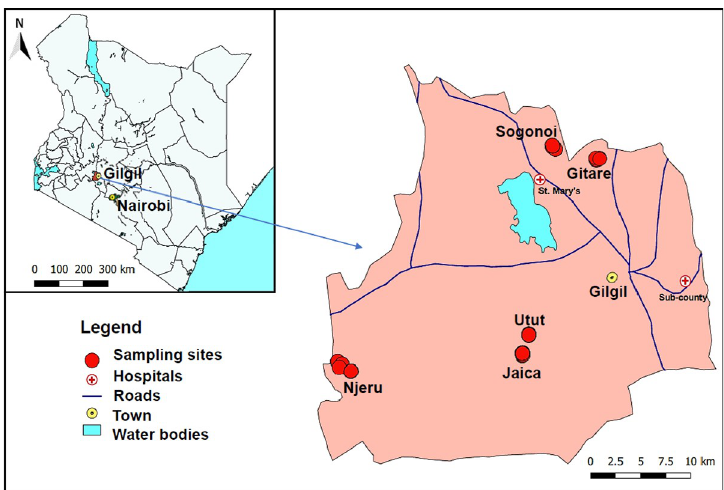
Fig 1. Map of Kenya (inset) and Gilgil Sub-county showing the location of the trapping sites. Gilgil covers an area of approximately 1348.4 Km 2 and has a population of 138,448 people. Lowest temperatures are experienced in June and July while the highest temperatures occur from December to February. The map was designed using QGIS (v